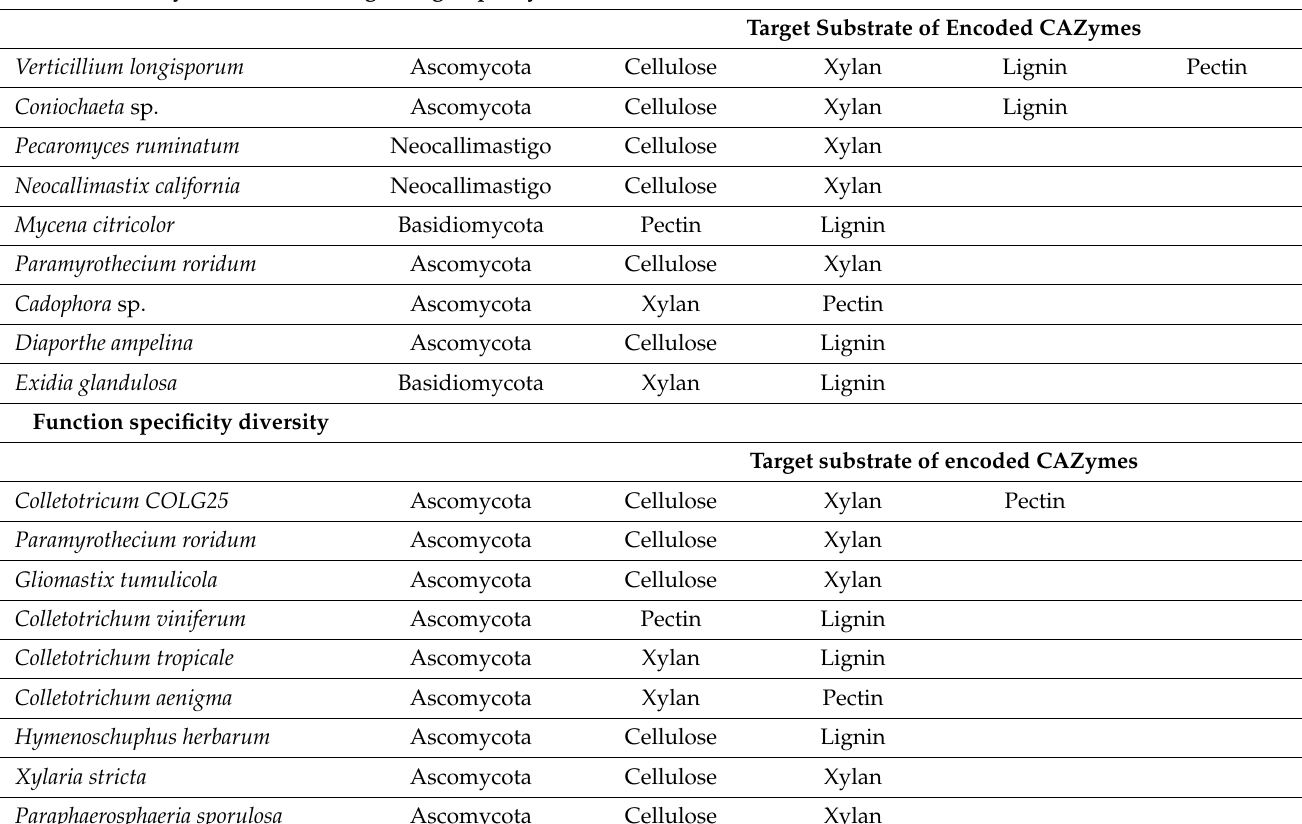
Table 5. Overview of the fungal species, which on two or more substrates rank among Top10 of all 1932 fungal genomes analyzed; Total carbohydrate biomass degrading capacity: According to total degrading capacity, including all obser- vations;Function specificity diversity: according to richness in function specificity diversity of CAZymes. Two species stands out, V. longisporum in total degrading capacity on all four substrates; and Colletotrichum COLG25 in enzyme function specificity